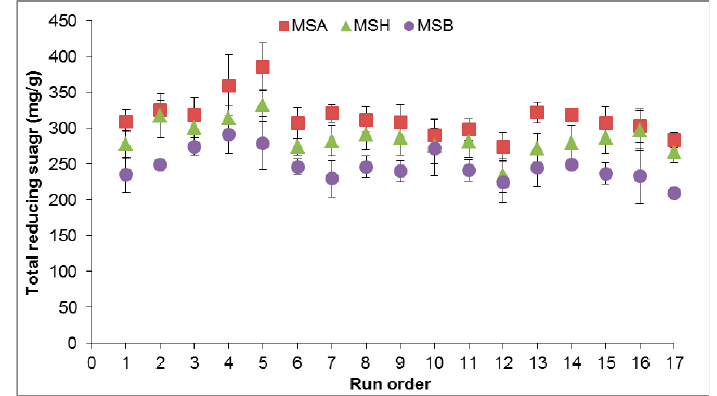
Figure 1. Total reducing sugar measured after enzymatic hydrolysis of sago palm bark for MSA, MSH, and MSB pretreatments. Table 3. Glucose and xylose yield after enzymatic hydrolysis of sago palm bark for MSA, MSH, and MSB pretreatments.